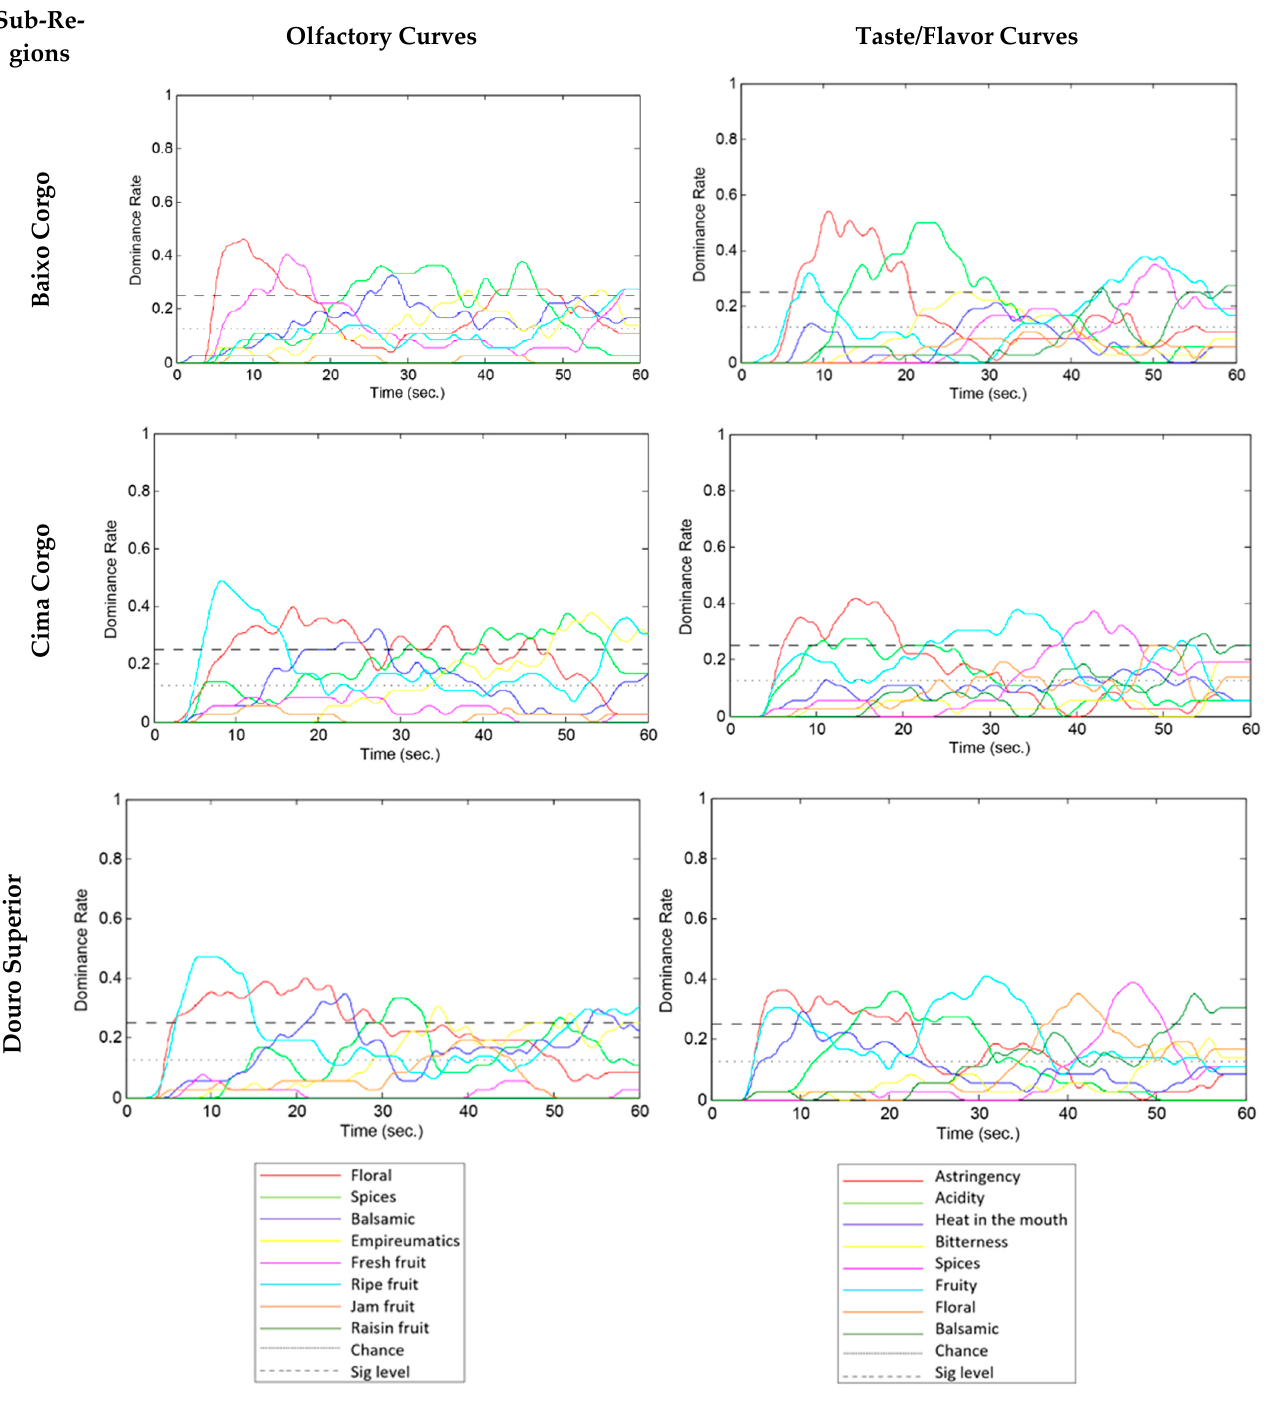
Figure 3. TDS curves of olfactory and gustatory attributes of the wines evaluated by the PP2 tasting panel. For each attribute, a colored line is presented in each graphic. Table 8. Quantitative parameters of the TDS curves—Olfactory and taste/flavor analysis of the wines from the three sub-regions of the DDR. s—time in seconds.